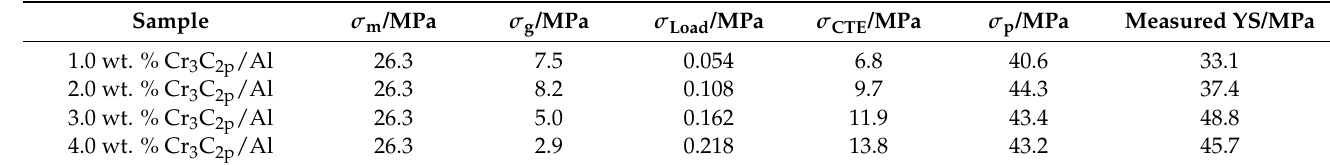
Table 2. The final predicted result and experimental result of the yield